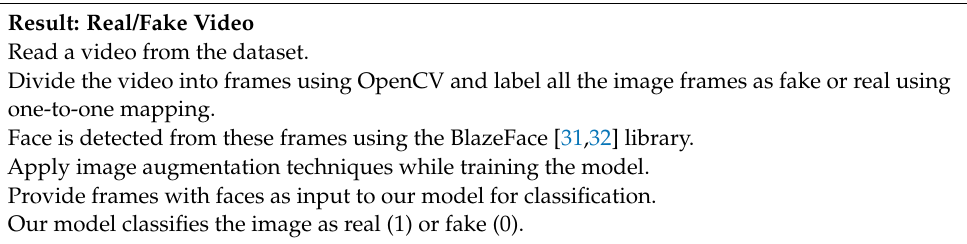
Algorithm 1: Algorithm for DeepFake Video